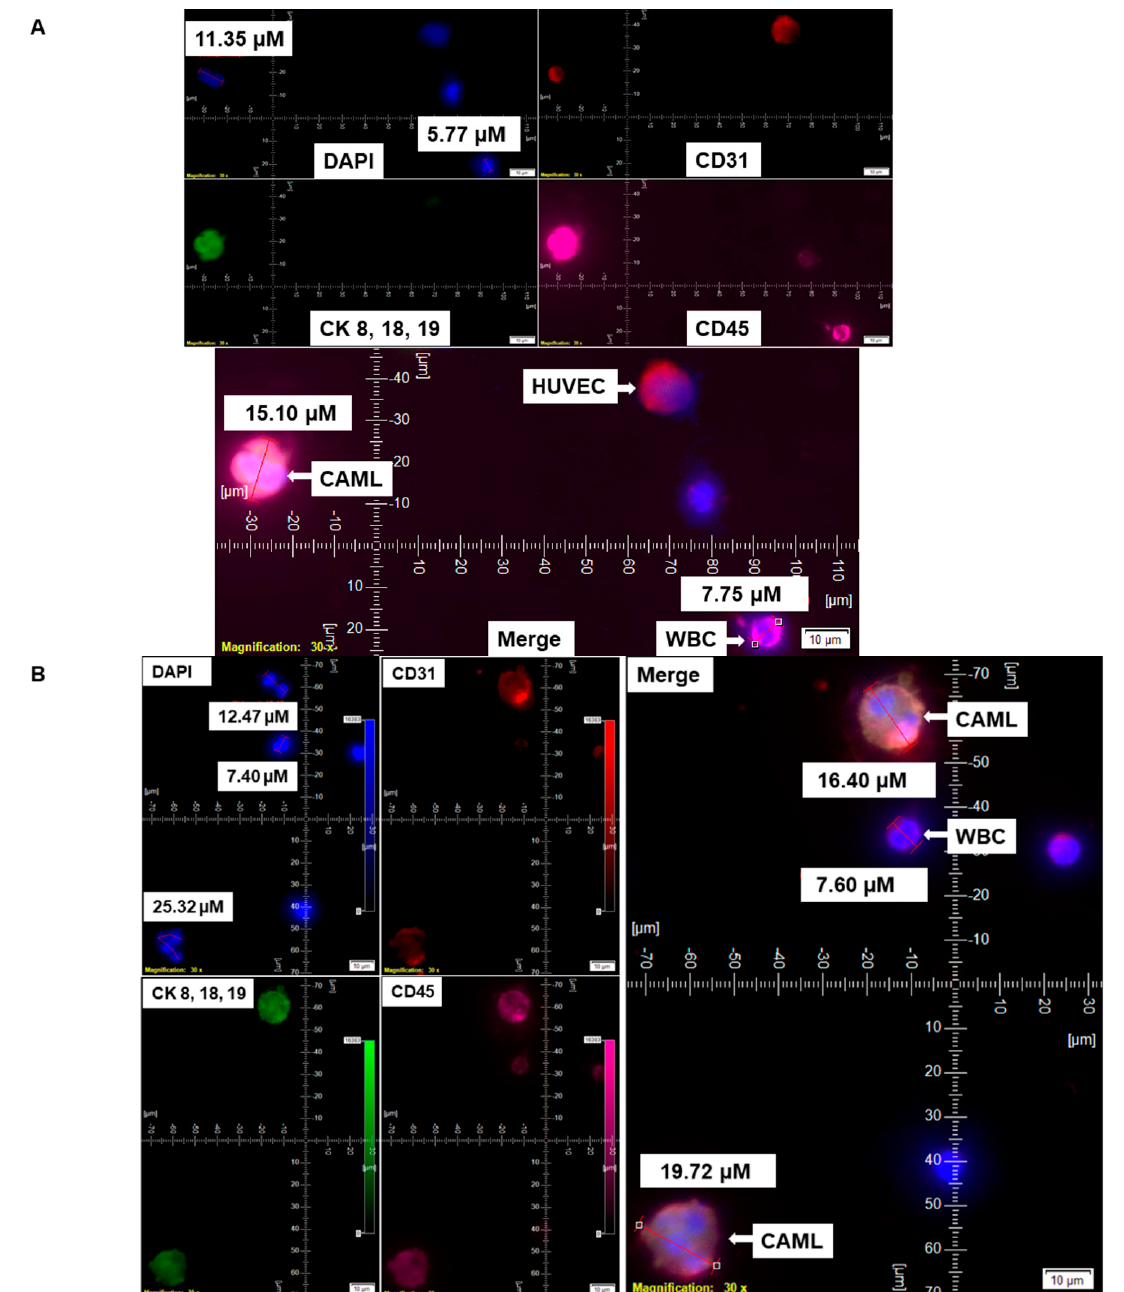
Figure 2. Identification of CD31 positivity of CAMLs in the blood of patients with endometrial cancers. CD31 positivity of CAMLs was tested using CAML tested by a CD45-Cy5/CK 8,18,19- FITC/CD31-PE immuno-fluorescence kit. CD31 positivity was validated in spiked blood samples with HUVEC cells, which are CD31 + /CK 8,18,19 − /CD45 − /DAPI + as the internal positive control ( A ) and in CAMLs from 7.5 mL of patient blood, which are CD31 + /CK 8,18,19 + /CD45 + /DAPI + ( B ) in contrast to CD45 + /CK 8,18,19 − /CD31 − /DAPI + WBCs. Pictures were taken with a 60 X oil objective using an Olympus IX71 microscope with DAPI/FITC/PE/CY5 filter sets. Cells were captured on a microfilter and stained with a CellSieve enumeration kit (Creatv Microtech) with DAPI/CK- FITC/CD31-PE/CD45-Cy5. The magnification, scale bar, and digital reticle are represented for each photomicrograph. Fluorescence images from the DAPI, FITC, TRITC and Cy5 channels were separated as pictures with a color bar. The fluorescence-photomicrographs present the diameters ( µ m) of a CTC and a representative WBC and their respective DAPI-stained